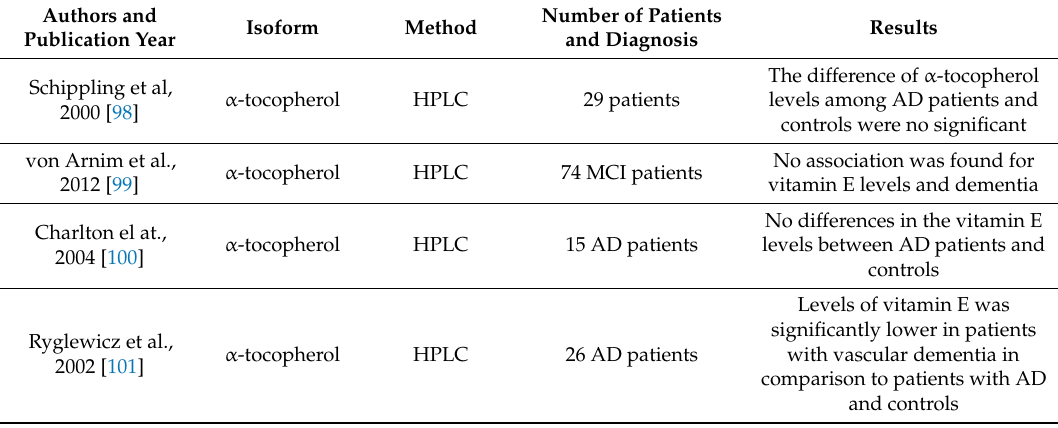
Table 2. Studies that don’t show a relation between AD and vitamin E